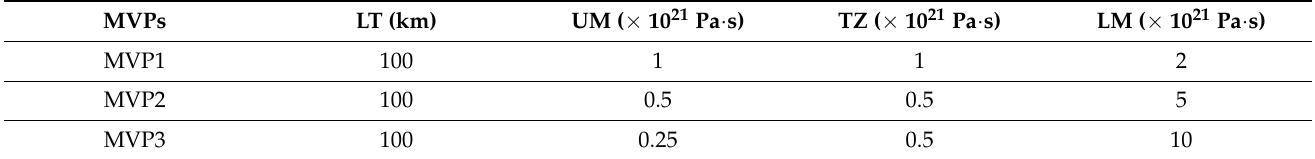
Table 6. Elastic lithosphere thickness and viscosity of the three-layer MVP 1–3